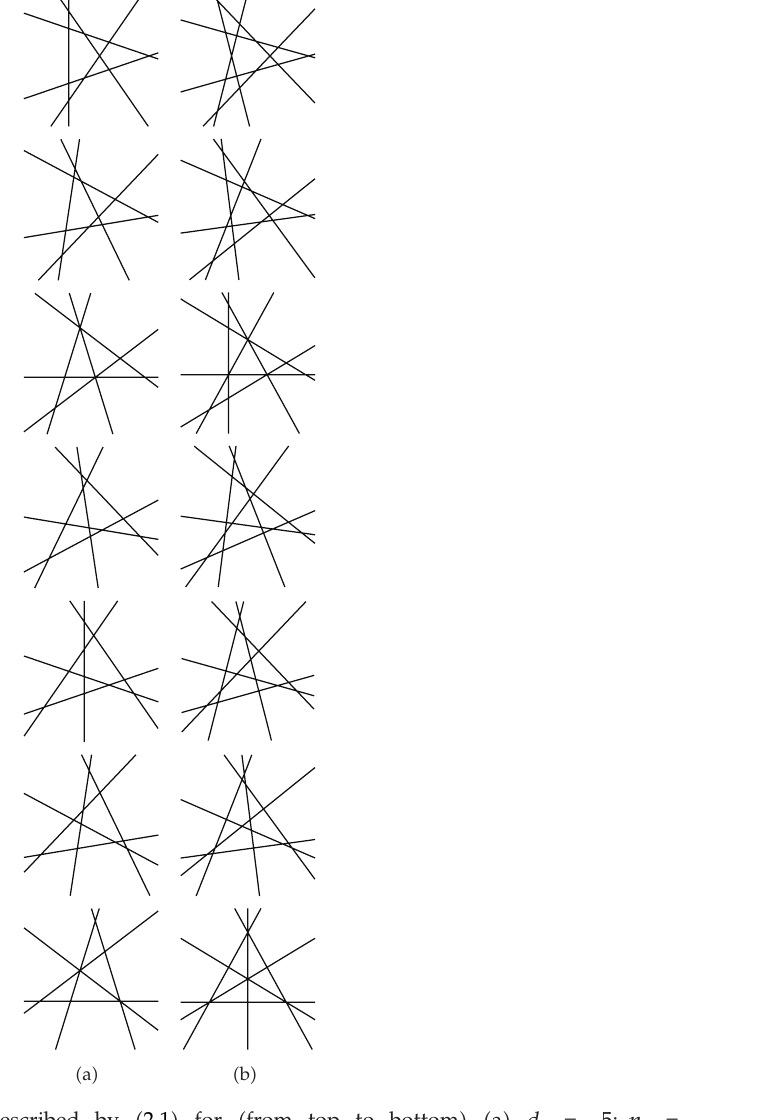
di ff erent shapes (cid:6) prototiles in S C (cid:7) . In both cases the prototiles have edges with three di ff erent lengths as in Section